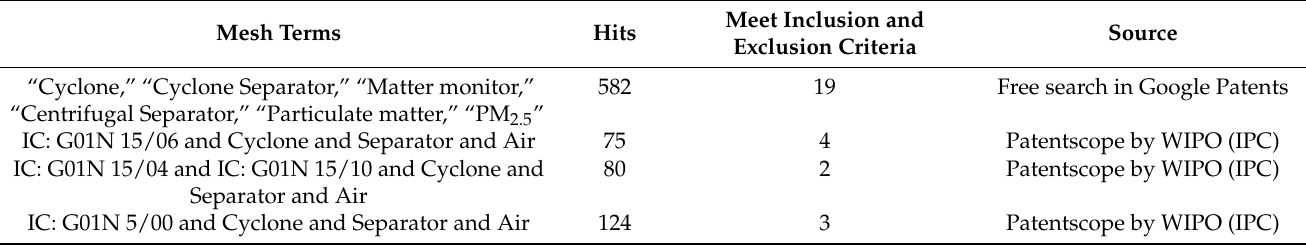
Table 3. Results from the search strategy.